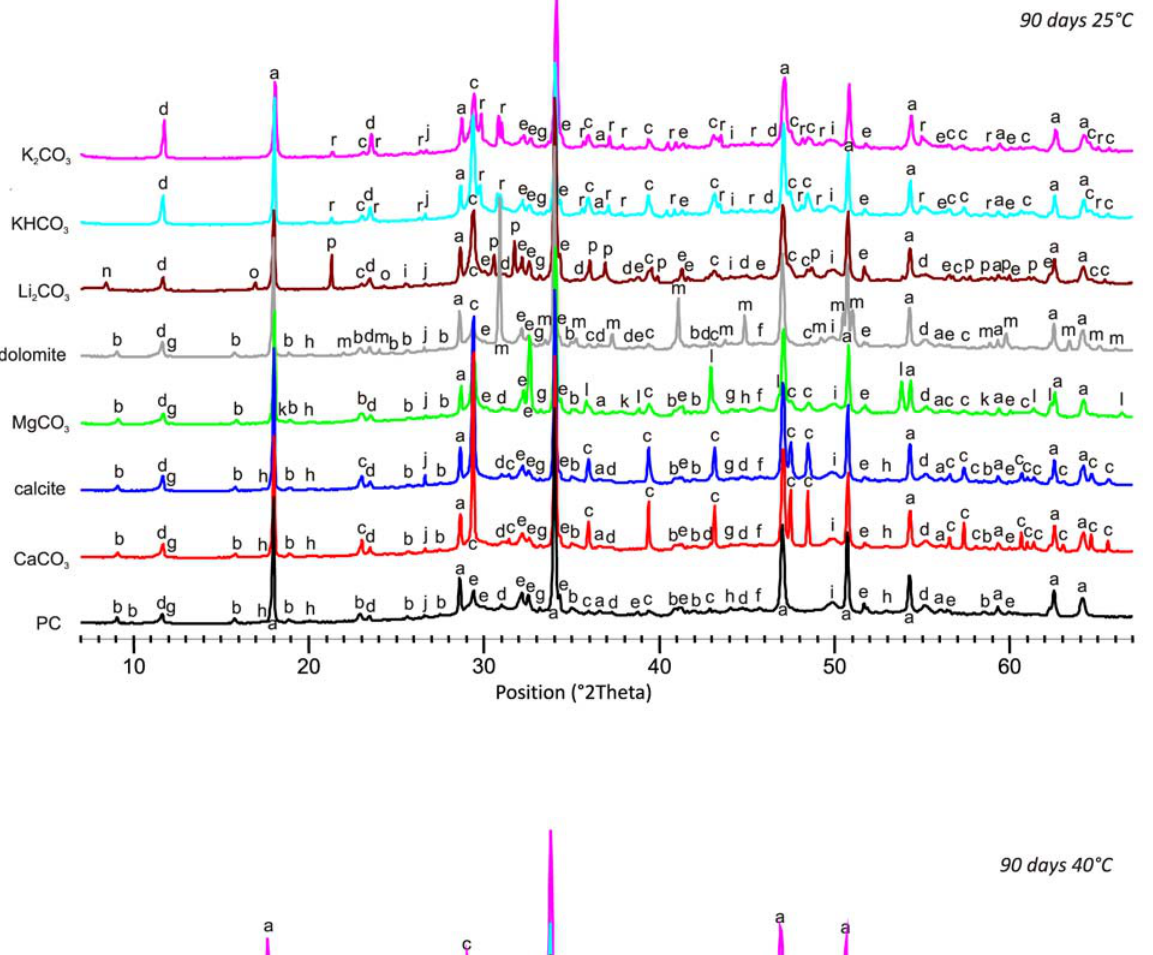
S; f-C S; 3 2 CO ; r-K SO 2 3 2 4